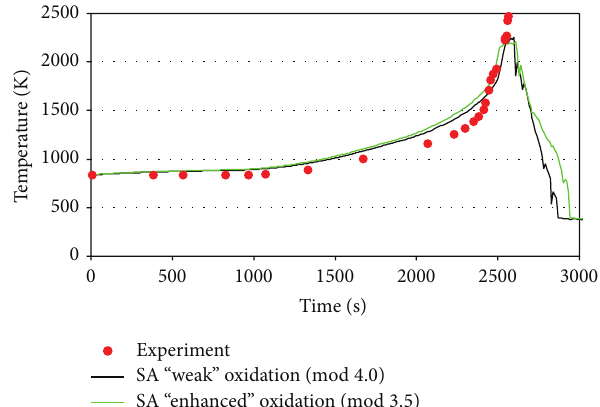
Figure 8: QUENCH-03 test calculation using RELAP/SCDAPSIM mod 3.2. The first approach of heat generation in “Cora” description. Fuel rod imitator cladding outer surface temperature in outer ring of bundle at 750 mm height.